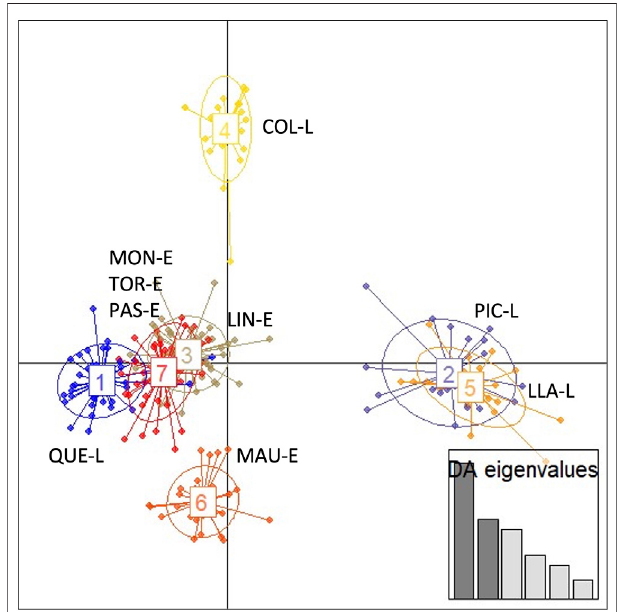
FIGURE4| Ordering ofthe Galaxias maculatus clustersidenti fi edby the discriminantanalysisofprincipalcomponents(DAPC)ofthedifferentlocations sampled. 1) Quetru Lake (QUE-L); 2: Pichilaguna Lake (PIC-L); 3: Lingue Estuary (LIN-E); 4: Colico Lake (COL-L); 5: Llanquihue Lake (LLA-L); 6: Maullín Estuary (MAU-E); 7: Moncul Estuary (MON-E) — Tortel Estuary (TOR- E)- Pascua Estuary